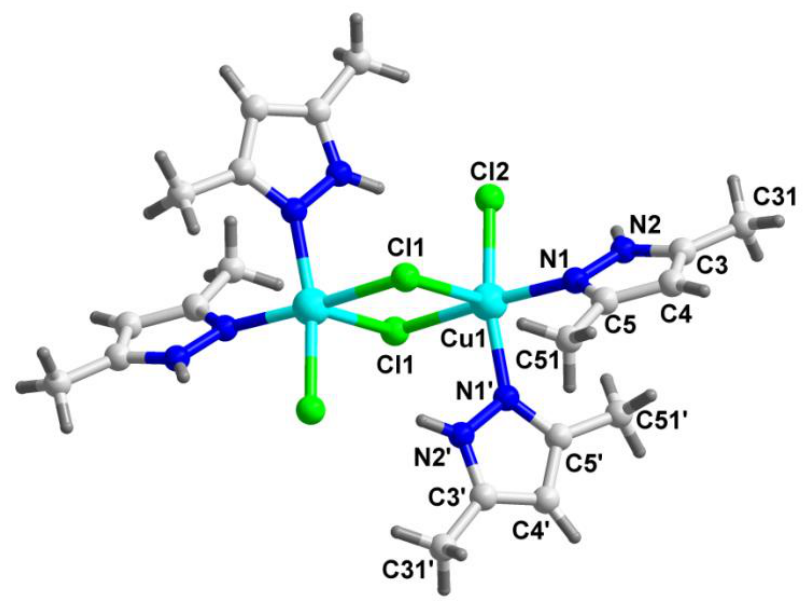
Figure 3. Molecular structure of [Cu 2 (µ-Cl 2 )Cl 2 (Hdmpz) 4 ] (compound 2 ).